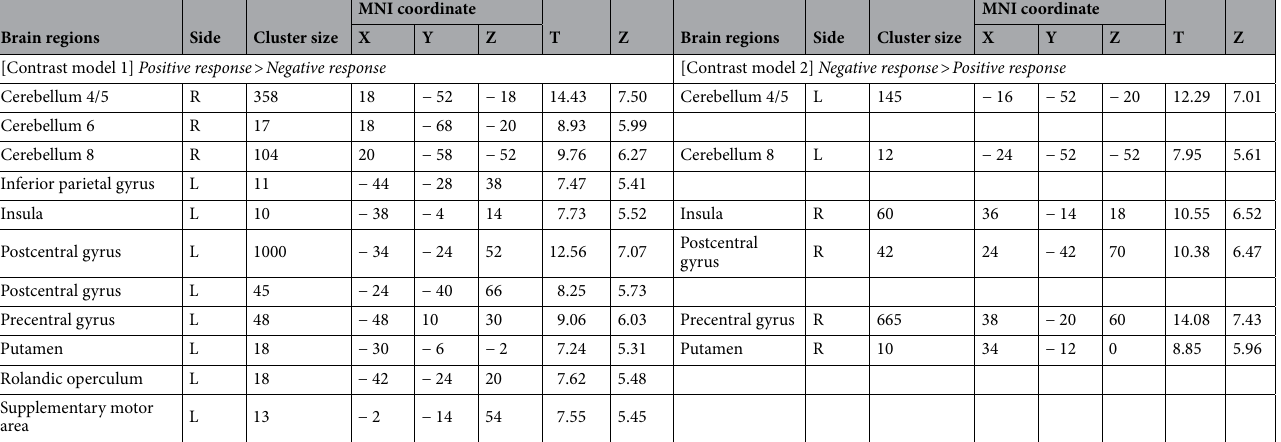
Table 1. MNI coordinates of results for contrast model 1 and 2. Row orders was sorted in alphabetical order with a few vacant rows to maximally visualize difference of two contrast models.